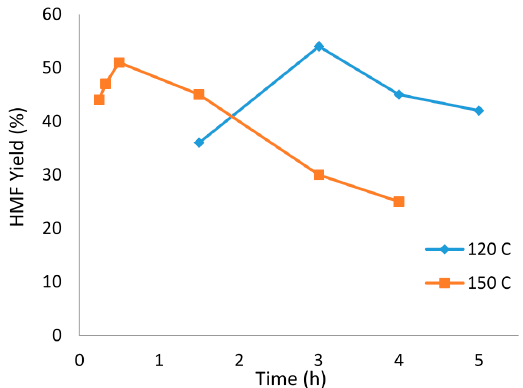
Figure 7. Yield of HMF from cellulose at 120 °C and 150 °C in [C 4 C 1 im]Cl; 0.1 g cellulose, 0.7 g ionic liquid; 7 mol % CrCl 3 ·6H 2 O catalyst. HMF yields shown were determined in the IL by 1 H NMR spectroscopy.